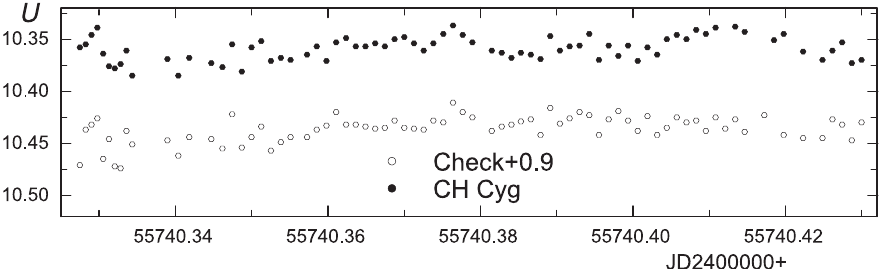
Fig. 4. High-time-resolution photometry of CH Cyg after the burst, on 2011 June